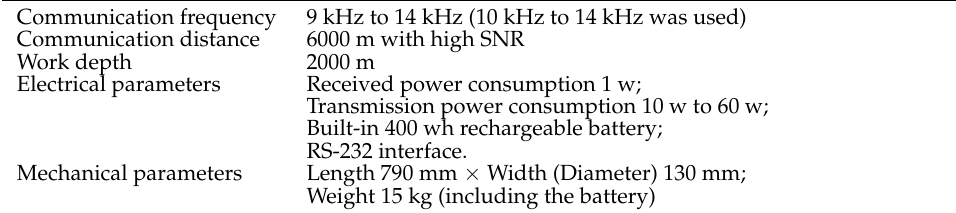
Figure 19. Dimension of underwater acoustic communication machine (Seatrix Modem). Table 4. Introduction of underwater acoustic communication machine (Seatrix